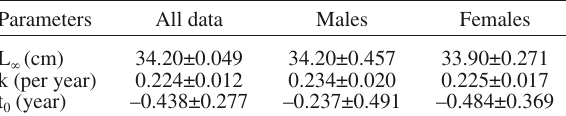
Table 2. – Growth parameters of all individuals, males and females, derived from the von Bertalanffy growth function of Labrus mixtus sampled in the eastern Adriatic Sea. All lengths are TL in cm ± SE.